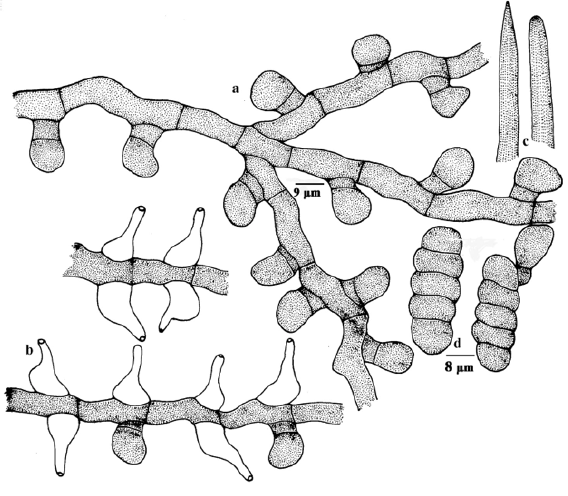
Figure 57. Meliola canthiicola a - Appressorium; b - Phialide; c - Apical portion of mycelial setae; d -